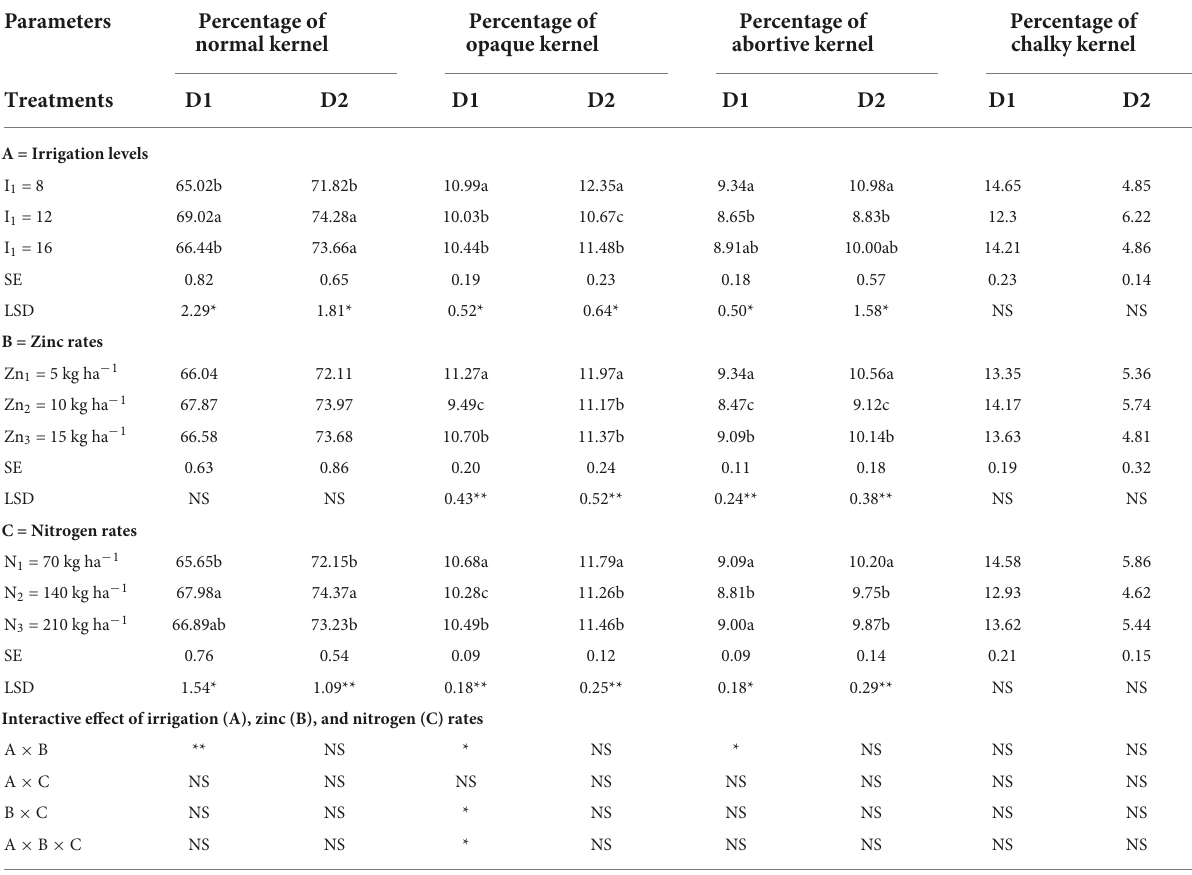
TABLE 4 Impact of zinc and nitrogen rates on percentage of normal, opaque, and abortive kernel of rice cultivated under three irrigation levels at Sheikhupura (D1) and Sargodha (D2) districts of Pakistan.